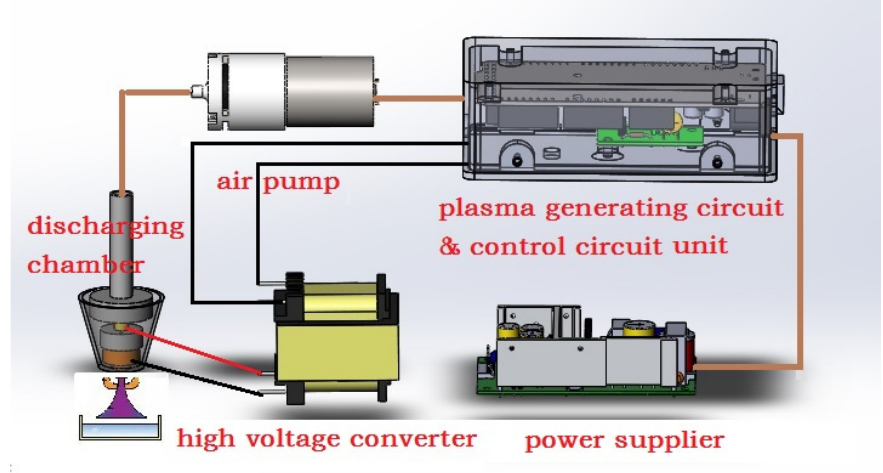
Figure 1. Schematic diagram of cold plasma generator used in this study.